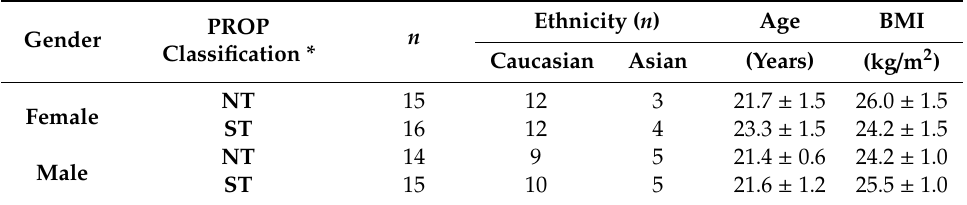
Table 1. Subject